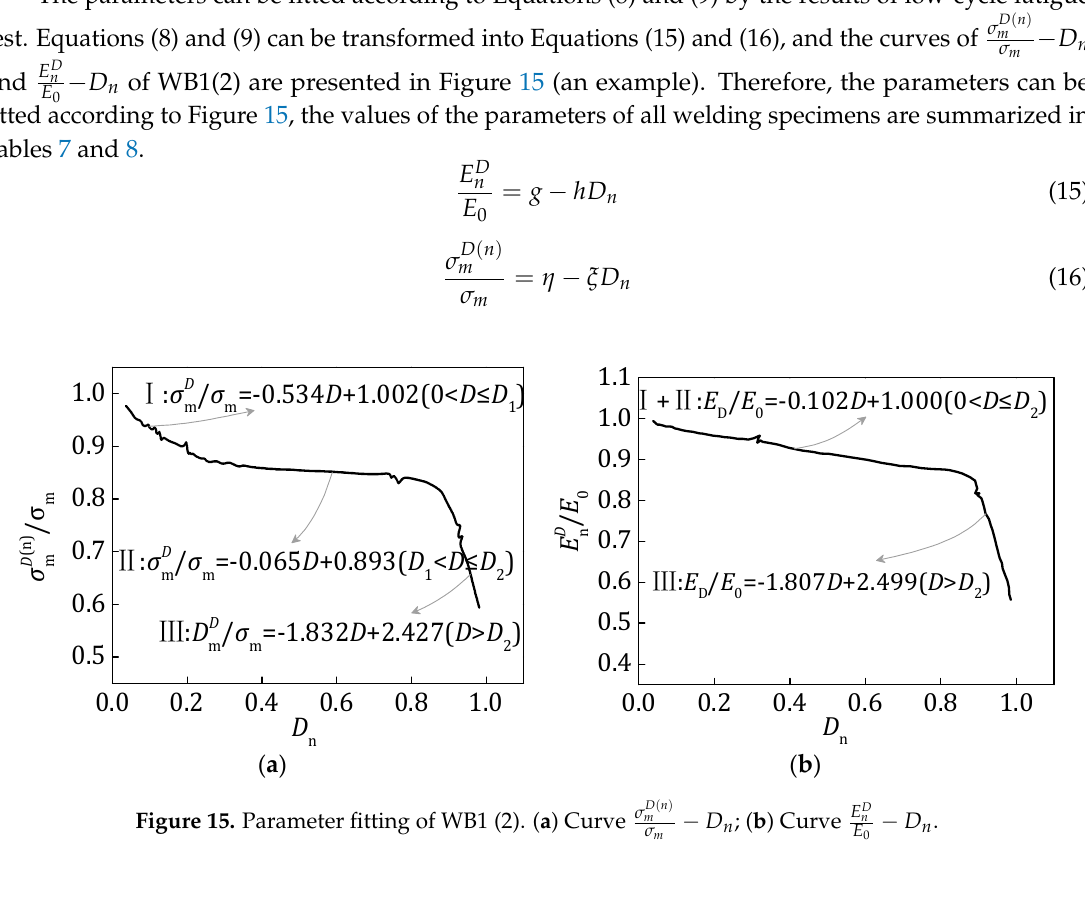
Table 7. Values of parameters η , ξ .